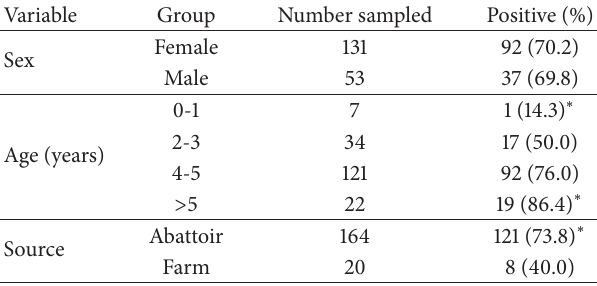
Table 2: Seroprevalence of AKAV in cattle in the study